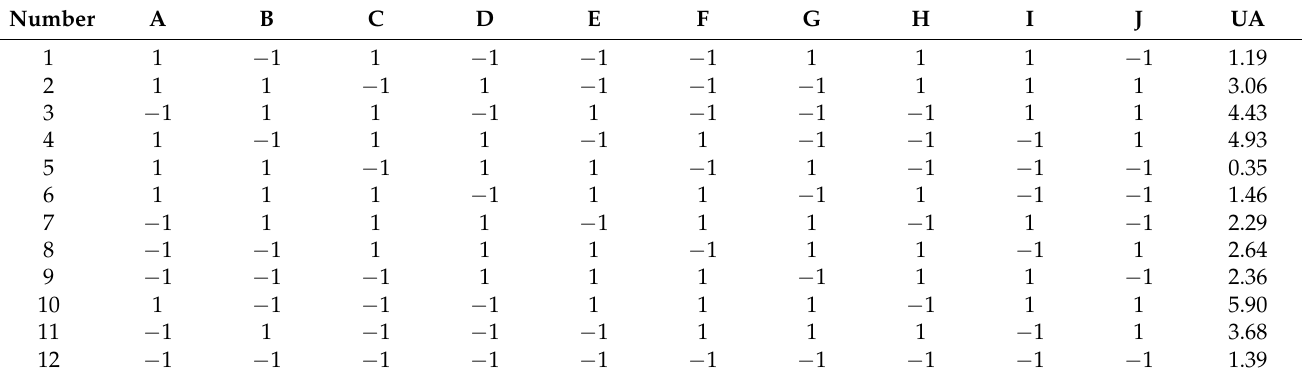
Table 3. Urease activity results from the PB tests.